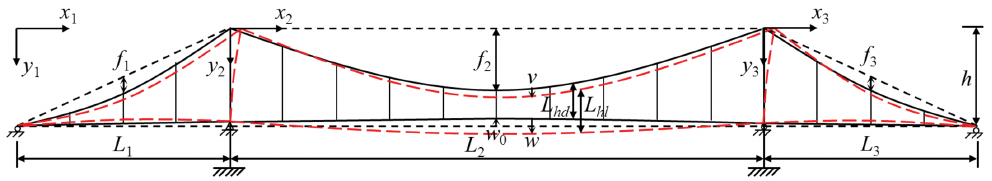
Figure 1. A typical three-span self-anchored suspension bridge